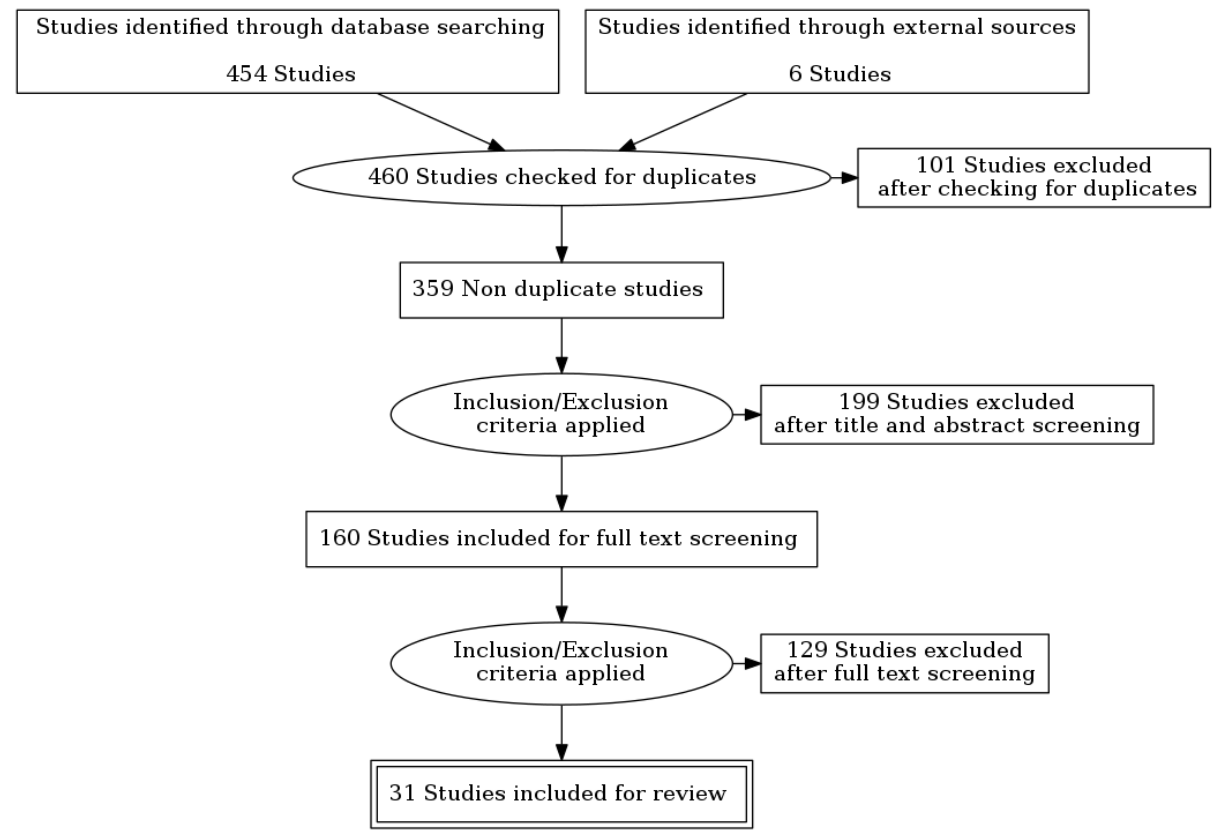
Figure 1. Study selection